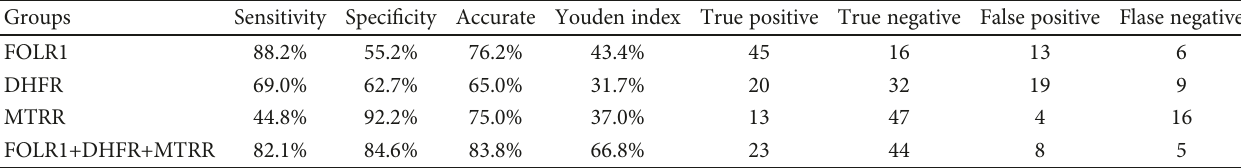
Table 3: Performance of FOLR1, DHFR, and MTRR in the di ff erential diagnosis drug-resistant cases from ovarian cancer patients. Groups